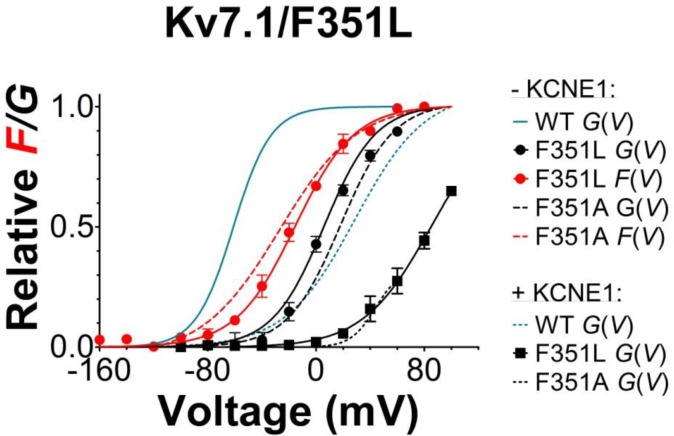
Voltage-clamp fluorometry recordings of the KV7.1/G219C*/F351L mutant with and without KCNE1 co-expressed.Mean F(V)/G(V) curves for KV7.1/G219C*/F351L (mean ± SEM) are shown together with corresponding mean F(V)/G(V) curves for WT KV7.1/G219C* (blue lines) and KV7.1/G219C*/F351A (dashed red/black lines). Experiments are performed and data normalized as described in Figure 3. Note that all data presented in this graph are done on constructs with a Kv7.1/C214A/C331A background (Barro-Soria et al., 2014; Barro-Soria and Perez, 2015). The F(V)/G(V) curves are therefore shifted towards negative voltages compared the data presented in Figure 3 (which are done in WT background). n = 4–6.